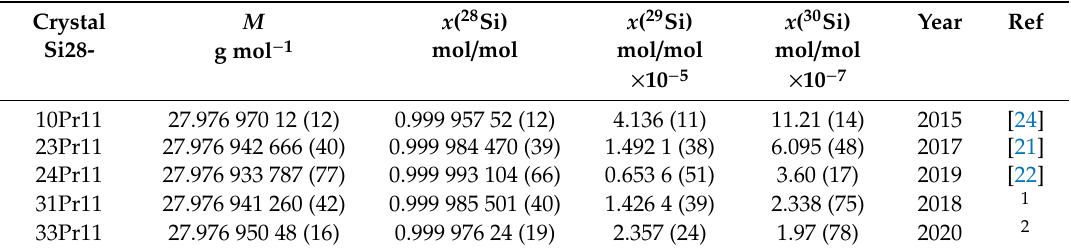
Table 4. Comparison of M and x ( i Si) of the available silicon spheres highly enriched in 28 Si used for the XRCD experiment (uncertainties for k =